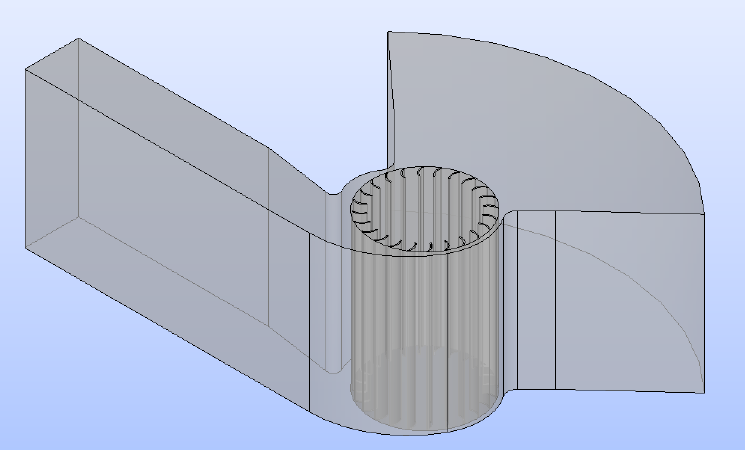
Figure 2. Eck/Laing CFF